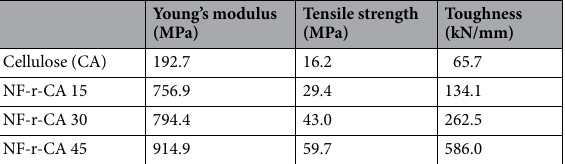
Table 1. The detailed Young’s modulus, tensile strength and toughness of the bare CA and NF-r-CA films (NF15-r-CA, NF30-r-CA and NF45-r-CA films) with different nanofiber